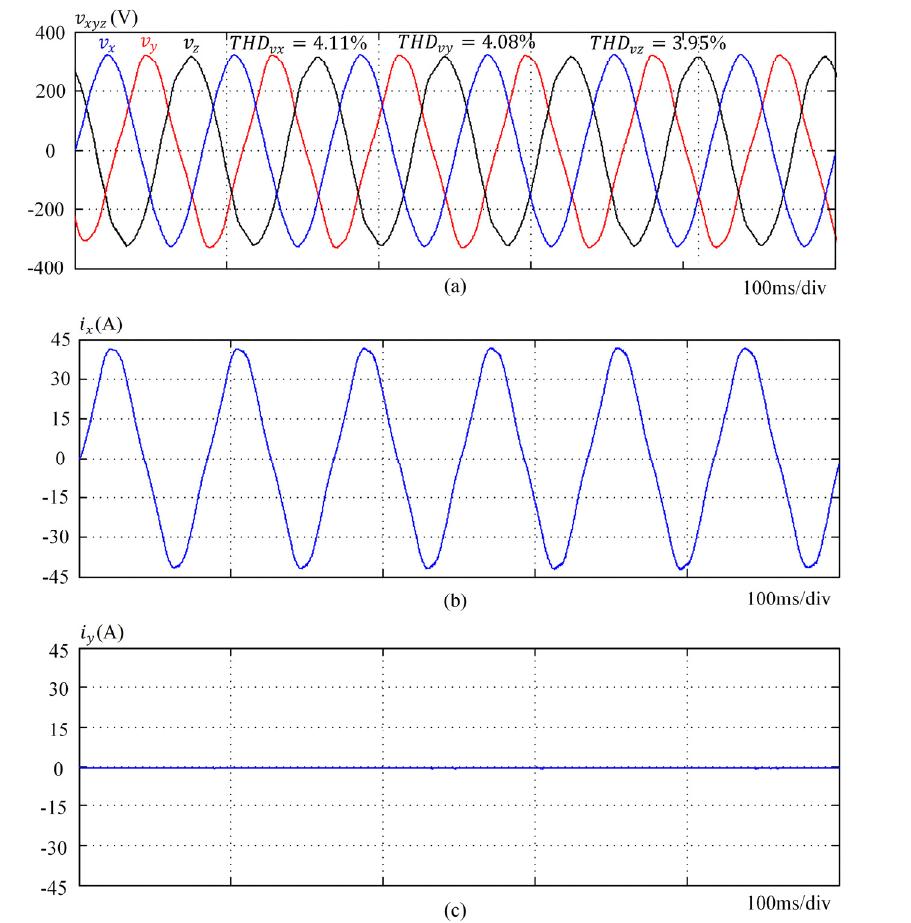
Figure 15. Output voltages of the transformers connected to unbalanced loads for a 10 kW power output: ( a ) output voltages of the transformers; ( b ) output current of the x-phase; and ( c ) output current of the